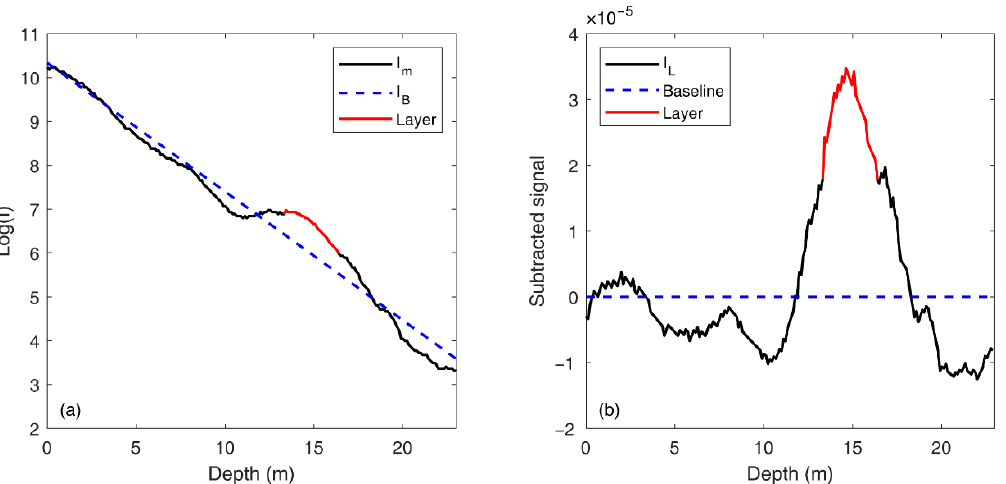
Figure 2. The processing of the lidar data. ( a ) Logarithm of photocathode current and background signal. The solid black line is the photocathode current I m ( z ) , the dashed blue line is the background signal I B ( z ) from linear fit, and the red part represents the range of layers; ( b ) The signal after subtraction. The black line is the signal from the layer, and the red part represents the range of its full width at half maximum .